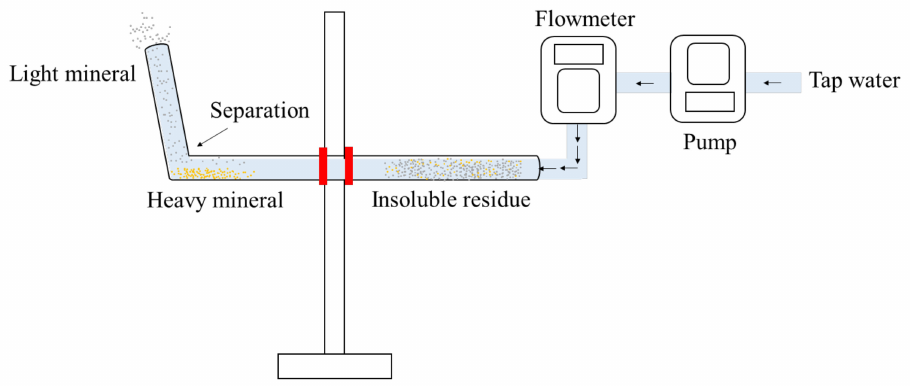
Figure 3. Schematic diagram of the hydro-separation